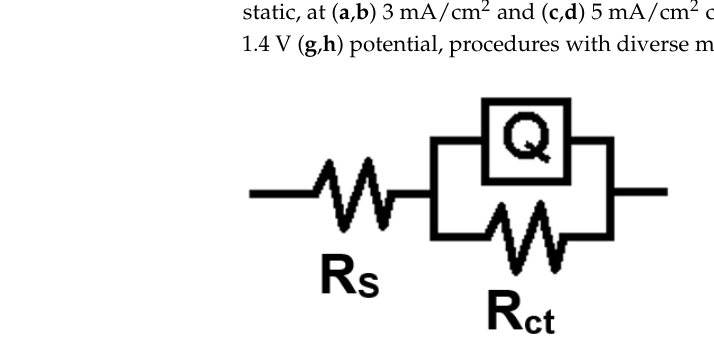
Figure 10. Equivalent circuit. The EIS results indicate that the charge transfer resistance R ct elevated and the double layer capacitance C dl lessened with composite coatings. As a result of increasing values of R ct with the PNMPY-TW20/P3MT coatings, the inhibition efficacy rose remarkably, which denotes that coating manifests valuable protection for the corrosion of the OLC 45 samples. The reduction in C dl can be possible by a lower local dielectric constant and/or increase in the thickness of the electrical double layer, a consequence of the existence of composite actuated by adsorption to the interface of the electrode/environment. The coat- ing electrodeposited onto the surface of the OLC 45 samples depicts a protecting layer onto the OLC 45 specimen. The Nyquist and Bode plots indicate that the action of corro- sion was impeded by deposition of PNMPY-TW20/P3MT coatings, and this situation is effectuated as a diffusion barrier via a charge transfer procedure. 3.5. SEM Studies Employing scanning electron microscopy (SEM), the morphology structure of the PNMPY-TW20/P3MT composite coatings attained over the OLC 45 substrate was exam- ined. The SEM images of PNMPY-TW20/P3MT coatings’ electropolymerization in several circumstances on the OLC 45 sample are depicted in Figure 11. These images display a thick black film of the PNMPY-TW20/P3MT acquired by the galvanostatic and potenti- ostatic procedure, designating that the coated composite was realized. ( a )